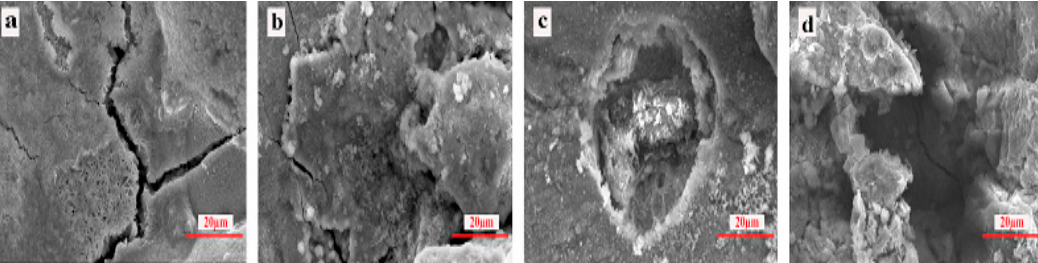
Figure 9. Scanning electron microscope (SEM) micrographs of the corroded surface of the 5083 alloy in 3.5% NaCl solution of the ( a ) annealed samples, as well as the ECAP samples after the ( b ) first, ( c ) second, and ( d ) third